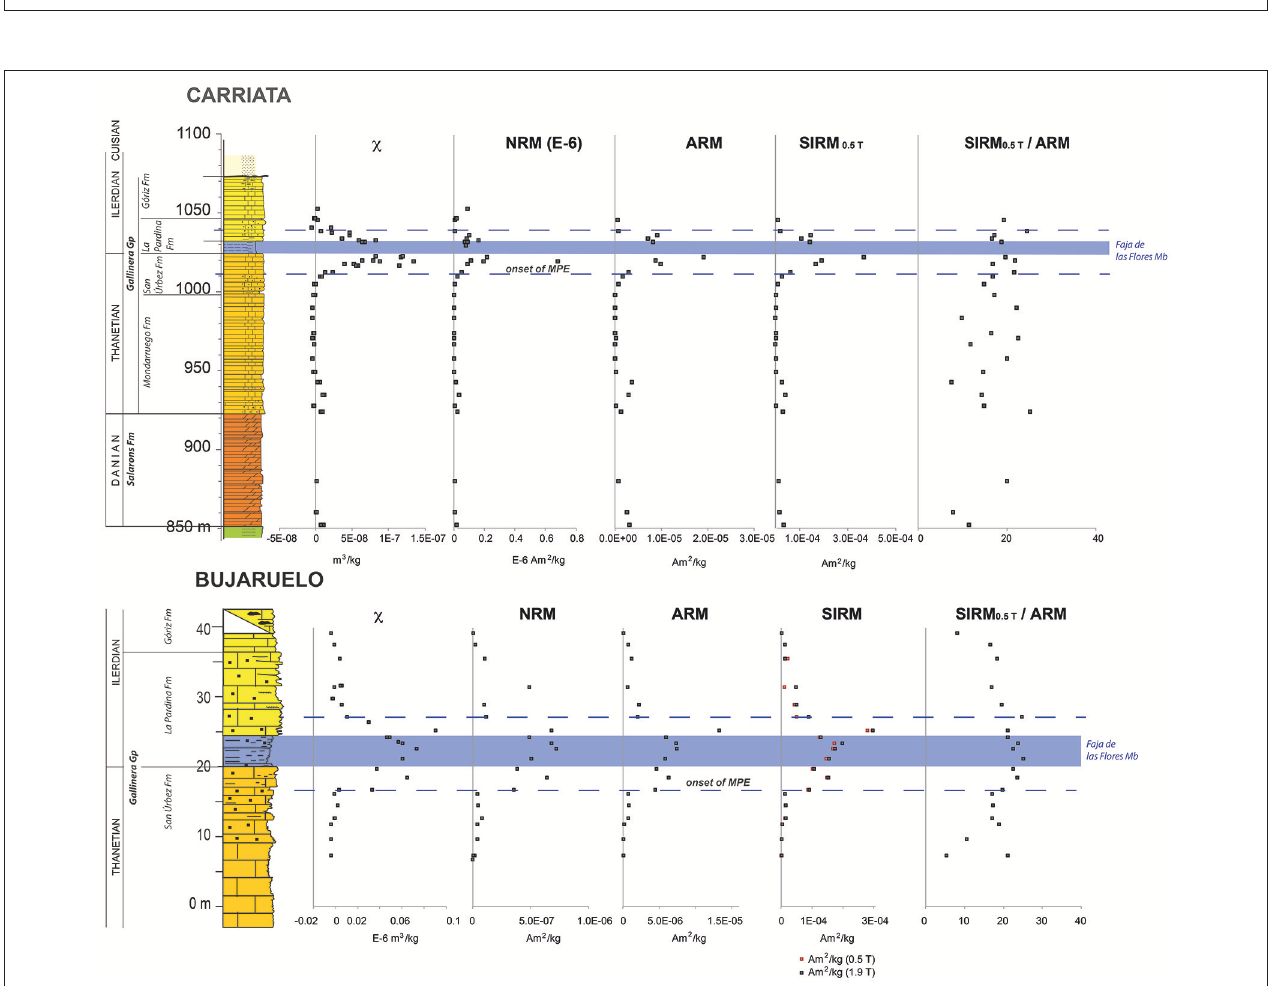
FIGURE 9 | Magnetic signal in Carriata and Bujaruelo sections, bulk magnetic susceptibility, NRM, ARM, SIRM, and SIRM 0.5T /ARM ratio. Discontinuous horizontal blue lines mark the positive “magnetic properties excursion” (MPE). The blue rectangle marks the Faja de las Flores Mb at the bottom of La Pardina Fm (following Pujalte et al., 2016). Vertical scale is variable. In the Bujaruelo section, the colors of the SIRM column represent two different applied fields: in red, 0.5T and in gray, 1.9T.